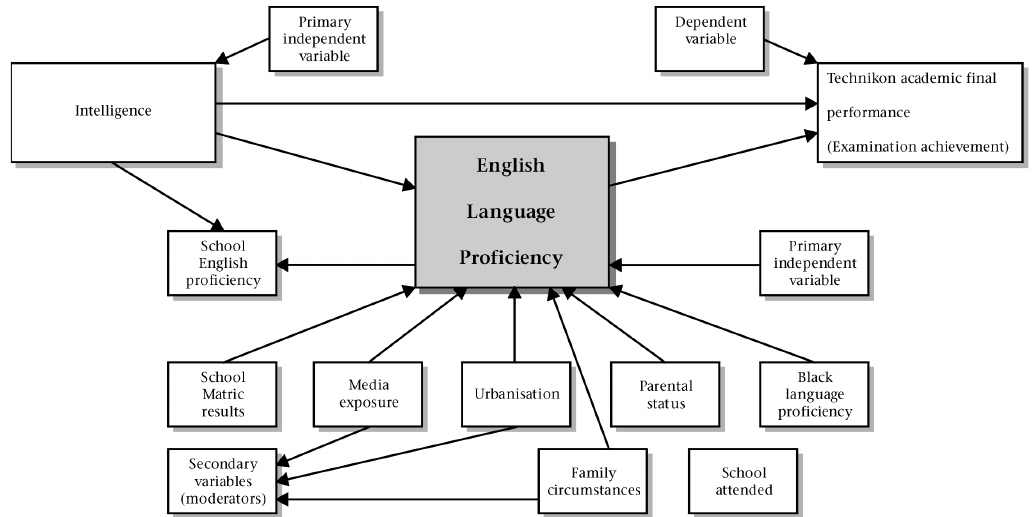
Figure 1: Some factors possibly influencing tertiary institution academic performance consequent upon English language